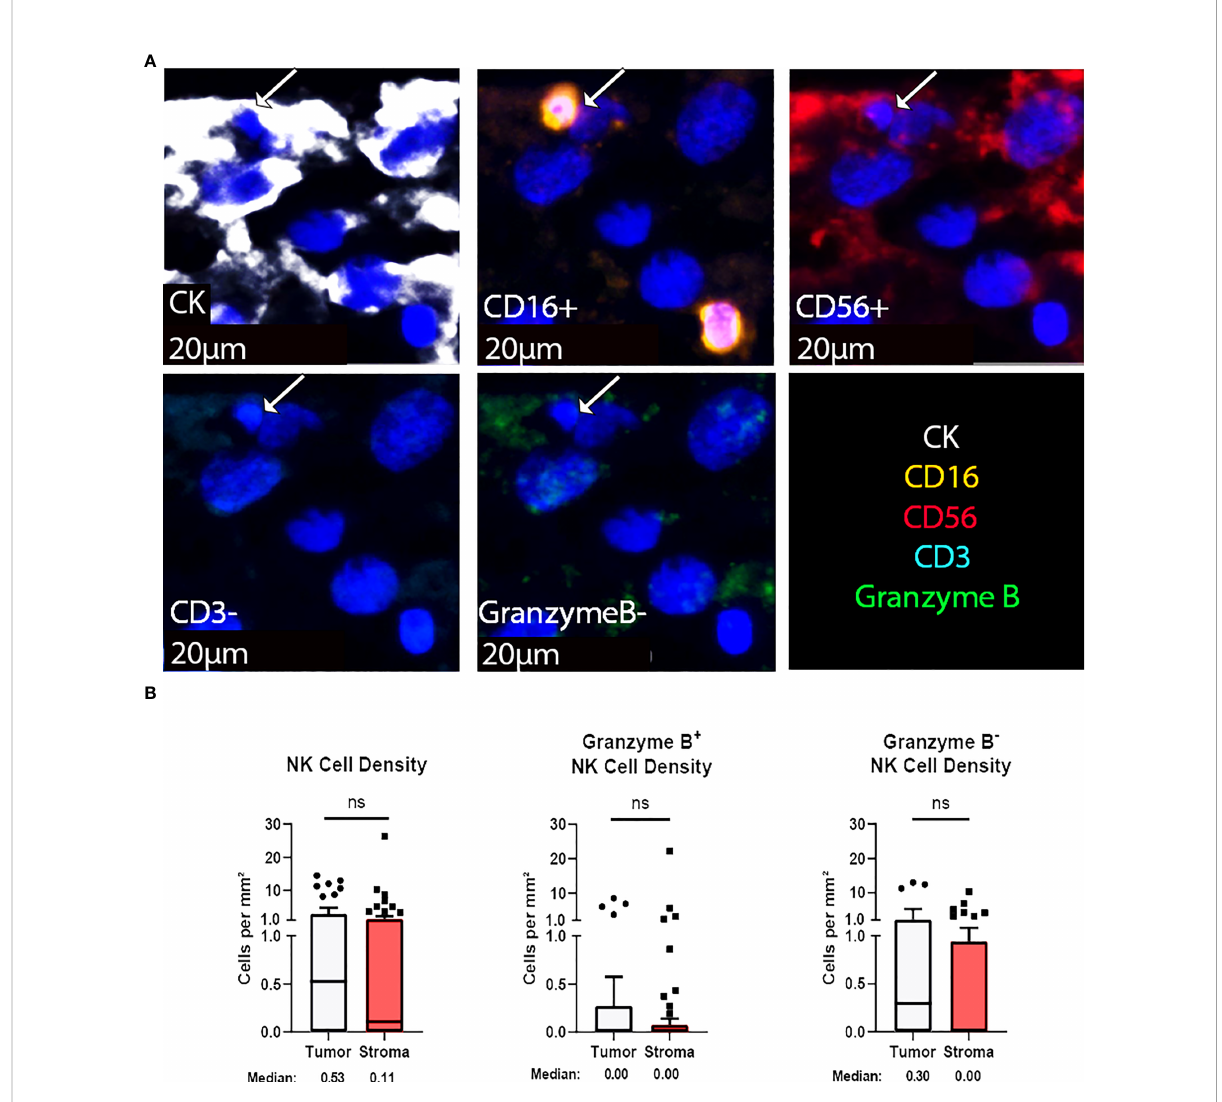
FIGURE 4 NK cells are sparsely found within the chordoma tumor immune microenvironment. (A) Representative photomicrographs from one chordoma of merged and single-color immuno fl uorescence images assessing the presence of NK cells with a validated panel of fi ve biomarkers, CD16 (orange, Opal 620), CD56 (red, Opal 690), CD3 (turquoise, Opal 480), Granzyme B (green, Opal 520), and CK (white, Opal 780). Multispectral immuno fl uorescence images are counterstained with DAPI. Co-localization of CD16 and CD56 without CD3 and a decrease size threshold compared to tumor cells identi fi ed NK cells. Expression of Granzyme B identi fi ed Granzyme B + or Granzyme B - NK cells. Expression of CK identi fi ed chordoma tumor cells. (B) Quanti fi cation of NK cells overall, Granzyme B + , and Granzyme B - NK cells per mm 2 in chordoma tumor and stroma (n = 54 individual tumors). Wilcoxon signed rank tests with p value threshold of <0.05 were used to compare tumor and stroma NK cell in fi ltrate. ns, non signi fi cant. NK cell, natural killer cell; CK, cytokeratin; DAPI, 4 ′ ,6-diamidino-2-